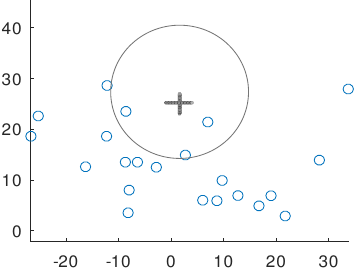
Figure 4. The constrained optimization model (the specific time t ) of finding a circle in 2D that is closest to all cell phone 20 position points.